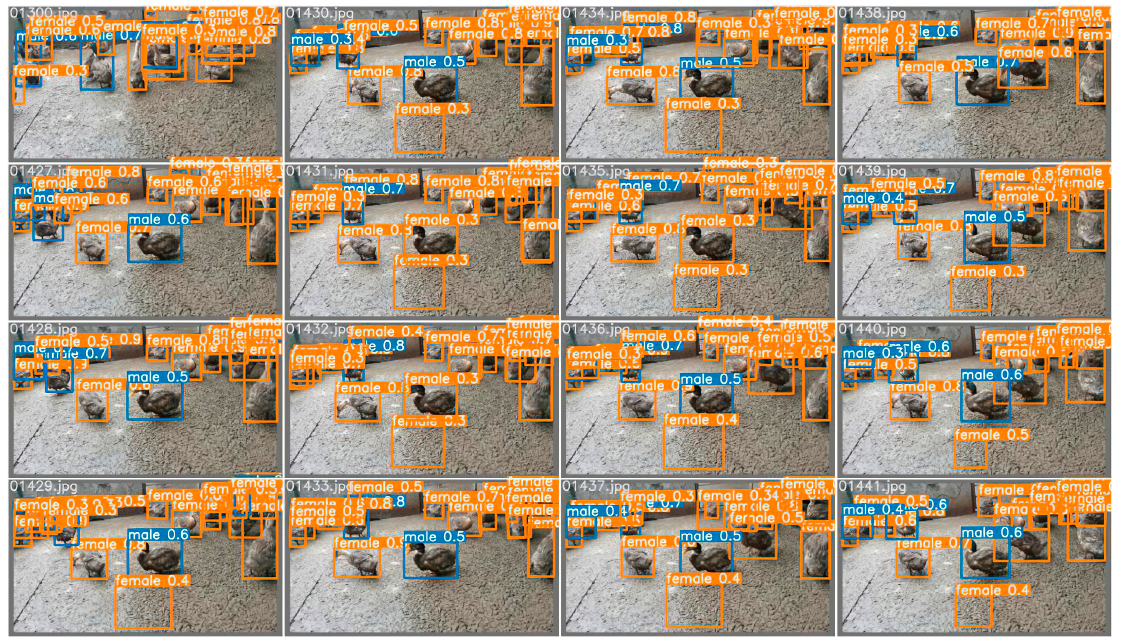
Figure 14. The sample results of scheme one. The locations, masking conditions, and individual be- haviors of the ducks vary in each extracted frame. As can be seen from the final validation map, some of the ducks were not identified, and some of those that were identified were incorrectly estimated.